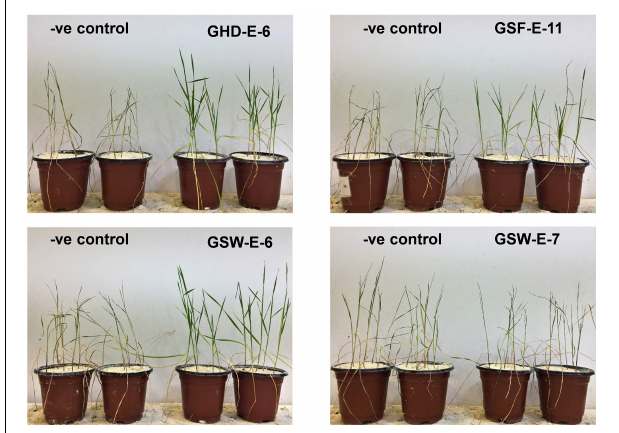
FIGURE 7 | Effect of inoculation with four PGPR bacterial strains, GHD-E-6, GSF-E-11, GSW-E-6 and GSW-E-7, on durum wheat cv. Tamaroi seedling after 10 days of water with-holding. –ve control: non-inoculated